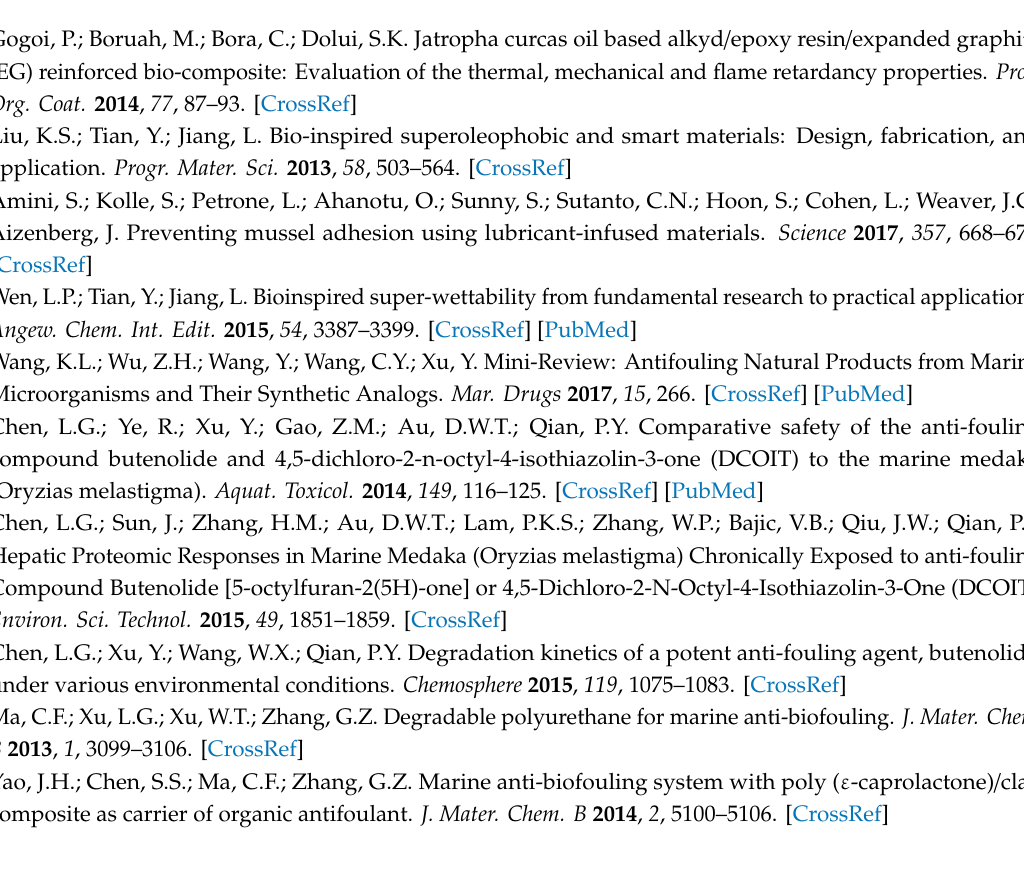
Figure S1: Water contact angle of (a) the coatings embedding the target microcapsules and (b) the coatings filling silicone oil; Figure S2: The slow-release e ffi ciency of